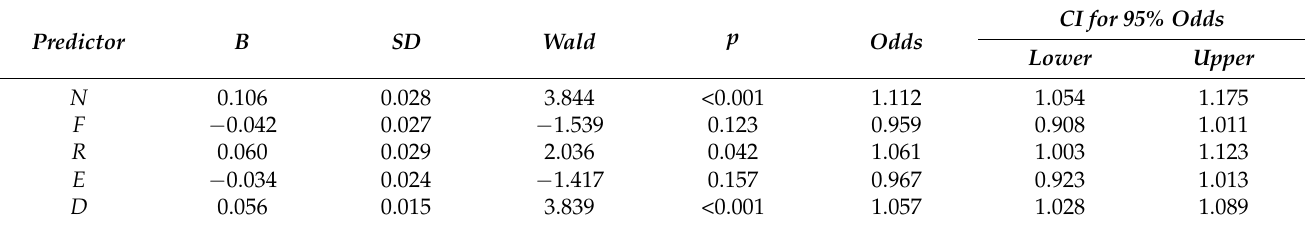
Table 3. Emotional exhaustion (EE) ˆ L s ( N , F , R , E , D ) = ˆ B 0 + ˆ B N N + ˆ B F F + ˆ B R R + ˆ B E E + ˆ B D D ; s = 1,2.